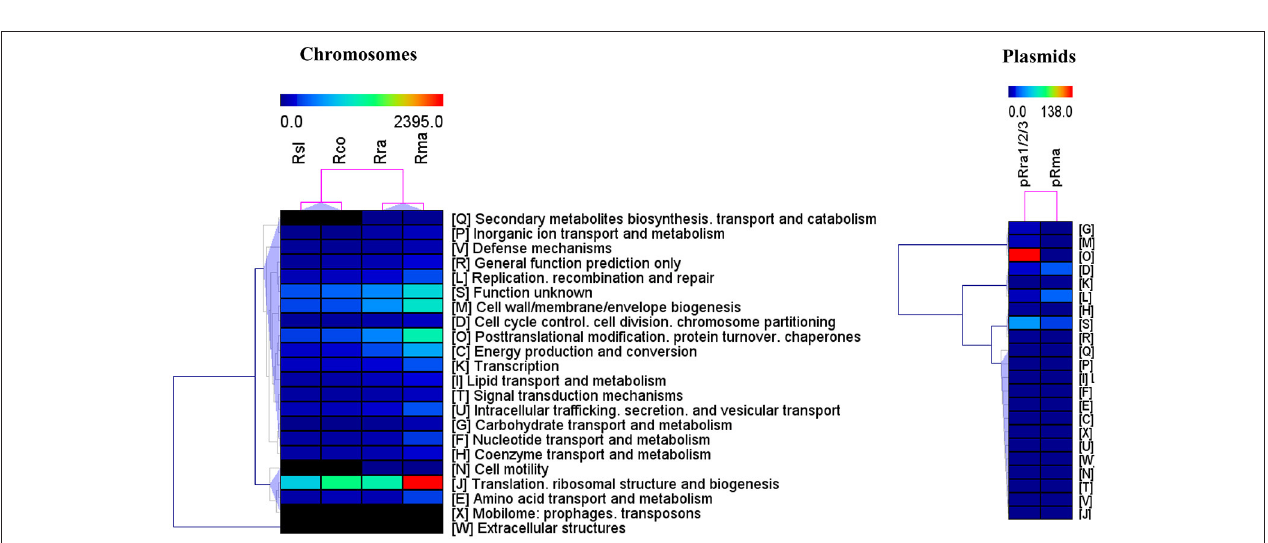
FIGURE 5 | Hierarchical clustering of total protein quantities (fmol µ g − 1 ) in the two virulent species R. slovaca Rsl and R. conorii Rco, and, the two milder species R. raoultii Rra and R. massiliae Rma, as classified by COG functional